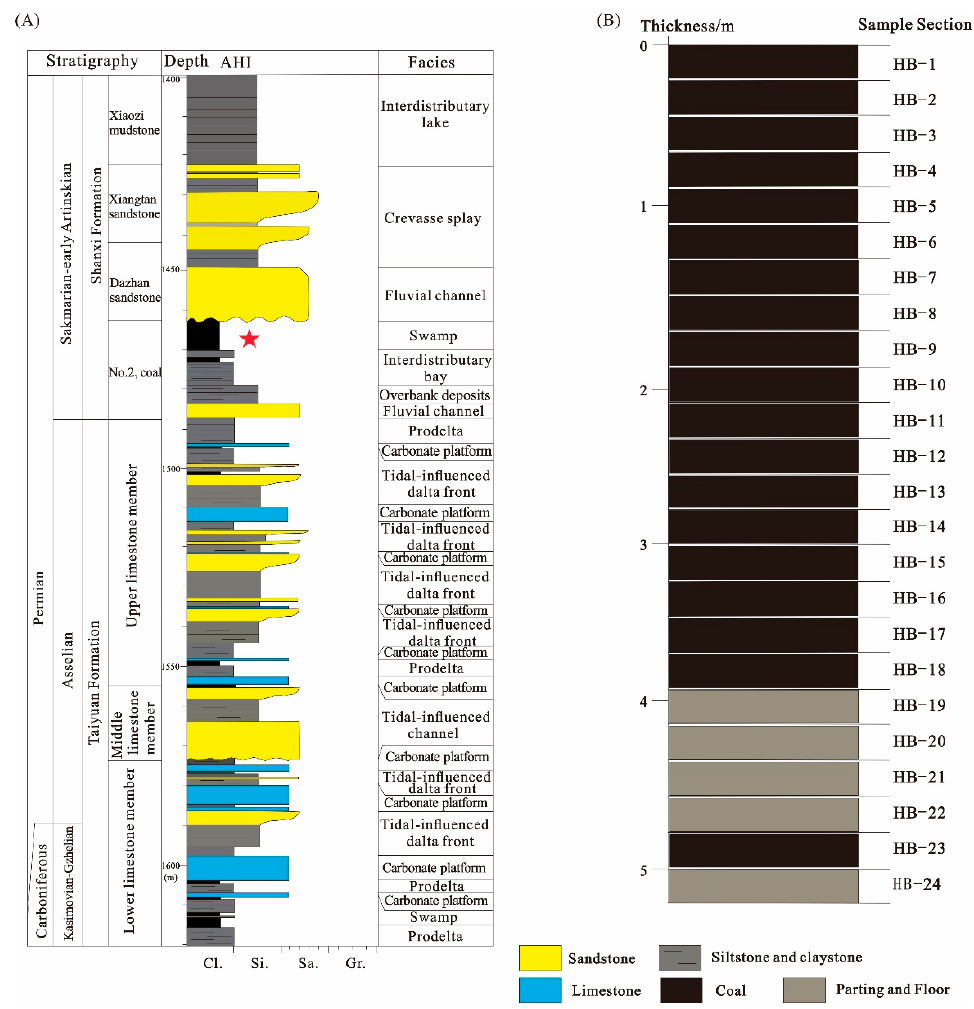
Figure 2. ( A ) Sedimentary sequences [71] and ( B ) the vertical sampled section of the No. 2 1 coal from the Hebi No. 6 mine, Anhe Coalfield. The red pentagram represents the coal seam studied in this paper.